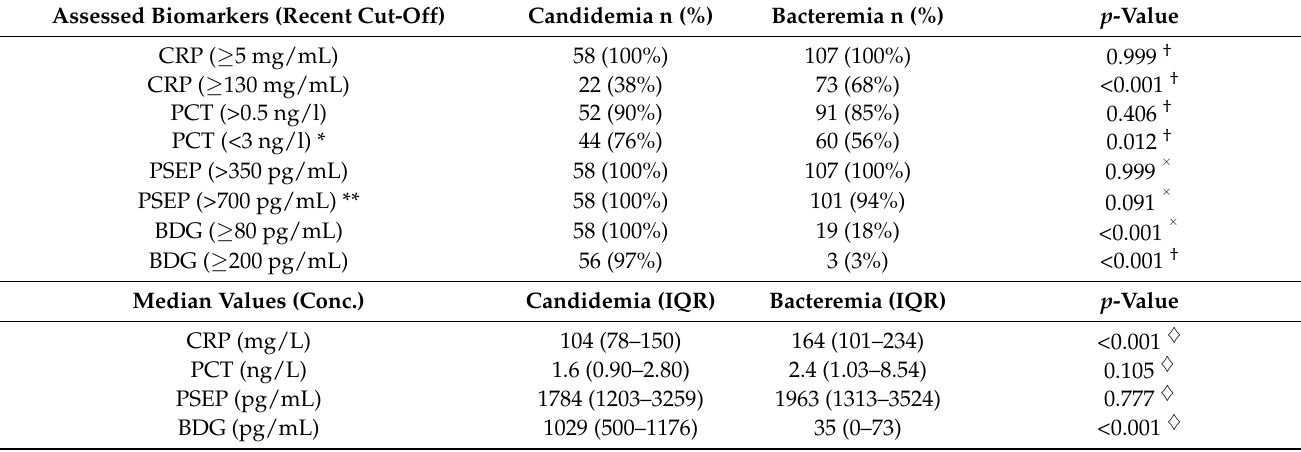
Table 2. Prediction and differential diagnosis of Candida and bacteria sepsis using biomarkers at different cut-off